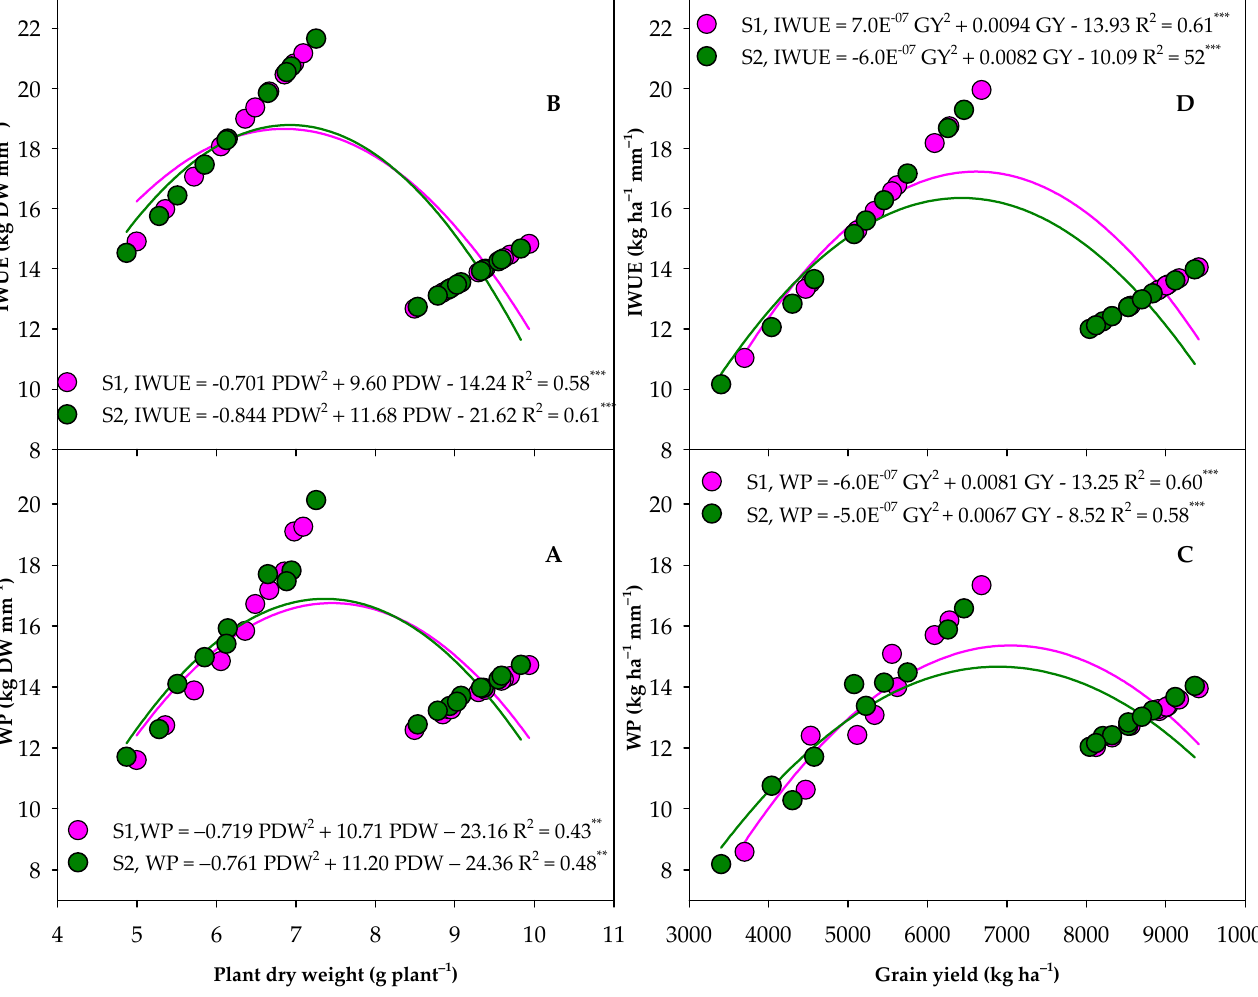
Figure 9. The fit regression models between of plant dry weight ( A , B ) and grain yield ( C , D ) with water productivity (WP) and irrigation water use efficiency (IWUE) in the first season (S1) and second season (S2). **, and *** indicate significant at p < 0.01 and 0.001, respectively.